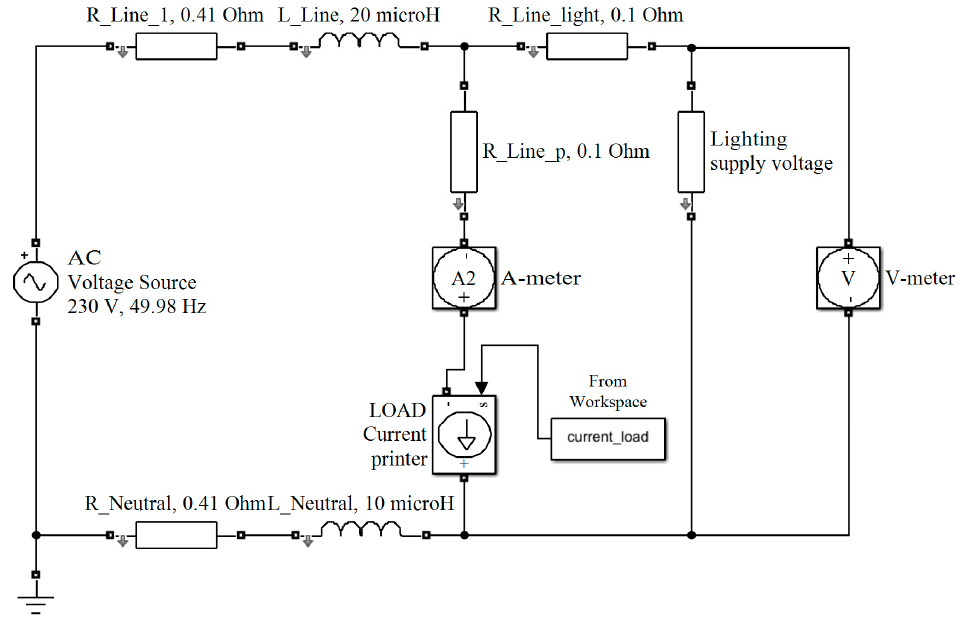
Figure 7. Matlab Simulink model of electrical installations for simulation of disturbances in the lighting supply voltage.